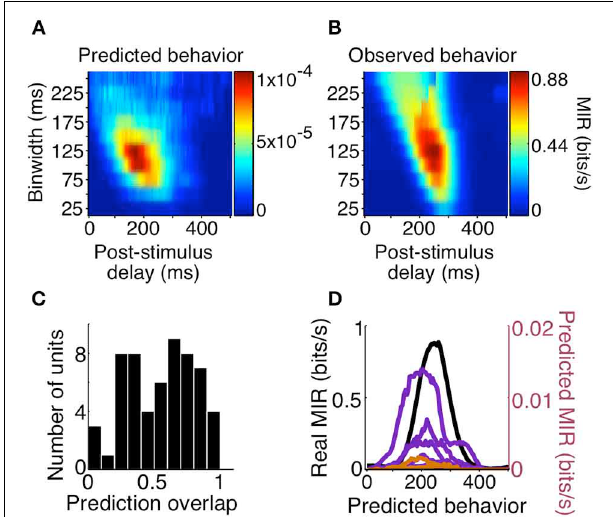
FIGURE 8 | Behavior predictions of same-sign units. We combined sensory and choice surfaces of same-sign units ( N = 69) to generate an average predicted behavior surface (A) which can be compared to the average of the real behavior surfaces ( B , same as Figure 5B ). A histogram of the overlap of the delay profiles of significant predicted ( N = 58) and real behavior information at a binwidth of 125ms is shown in (C) . The delay profiles of units with overlap >0.75 ( N = 13, orange and purple, colored by animal) and the average of real behavior (black) are shown in (D)